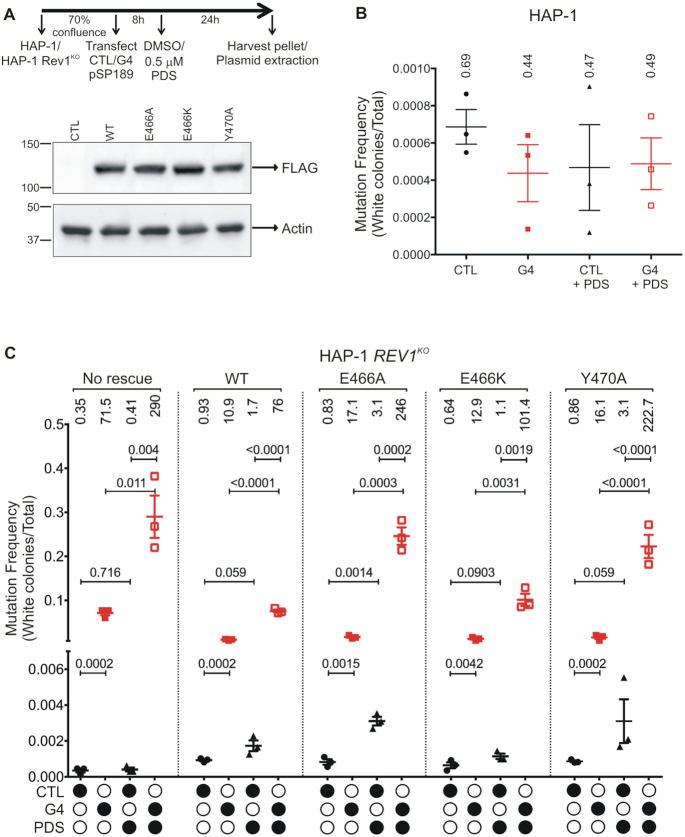
hRev1 plays an important role in suppression of mutations at sites containing G4 DNA sequences. (A) An overview of the supF mutagenesis experiments is shown. Briefly, wild-type HAP-1 and REV1KO cells were transfected with either the unmodified pSP189 plasmid (control) or the pSP189 plasmid containing a Myc-G4 sequence. This was followed by treatment with either vehicle (DMSO) or 0.5 μM pyridostatin (PDS). The cells were cultured for an additional 24 h. Then plasmids were extracted and used for blue-white screening by transformation into E. coli MBM7070 cells, followed by plating on to LB-Agar plates containing X-Gal and IPTG. Complementation supF mutagenesis experiments were performed similarly, using REV1KO cells co-transfected with SFB-tagged wild-type or mutant hRev11–1251. A Western blot of whole-cell lysates of REV1KO cells showing the relative protein expression of each of the transiently transfected SFB-tagged hRev11–1251 protein is shown. CTL - control (untransfected); WT - cells transfected with wild-type hRev11–1251; E466A - cells transfected with the E466A mutant hRev11–1251; E466K - cells transfected with the E466K mutant hRev11–1251; Y470A - cells transfected with the Y470A mutant hRev11–1251. The corresponding uncropped immunoblot images are shown in supplementary Supplementary Figure S5. The number of blue and white colonies were counted and the mutation frequency was calculated for each condition. A minimum of 10,000 colonies were counted for each replicate. Experiments were performed in triplicate and the results were plotted as mean ± SD (n = 3). The mutation frequencies calculated for the (B) HAP-1 and (C) REV1KO cells are shown. CTL - cells transfected with control pSP189 plasmid; G4 - cells transfected with the G4-pSP189 plasmid; PDS—cells treated with 0.5 μM PDS. For the complementation experiments in the REV1KO cells, the identity of the hRev1 variant used is noted above the data. The mean value of mutation frequency (× 10−3) is shown above each set of data points. Statistical significance was assessed by performing a pair-wise Student's t-test, and the P-value calculated is shown above each pair.